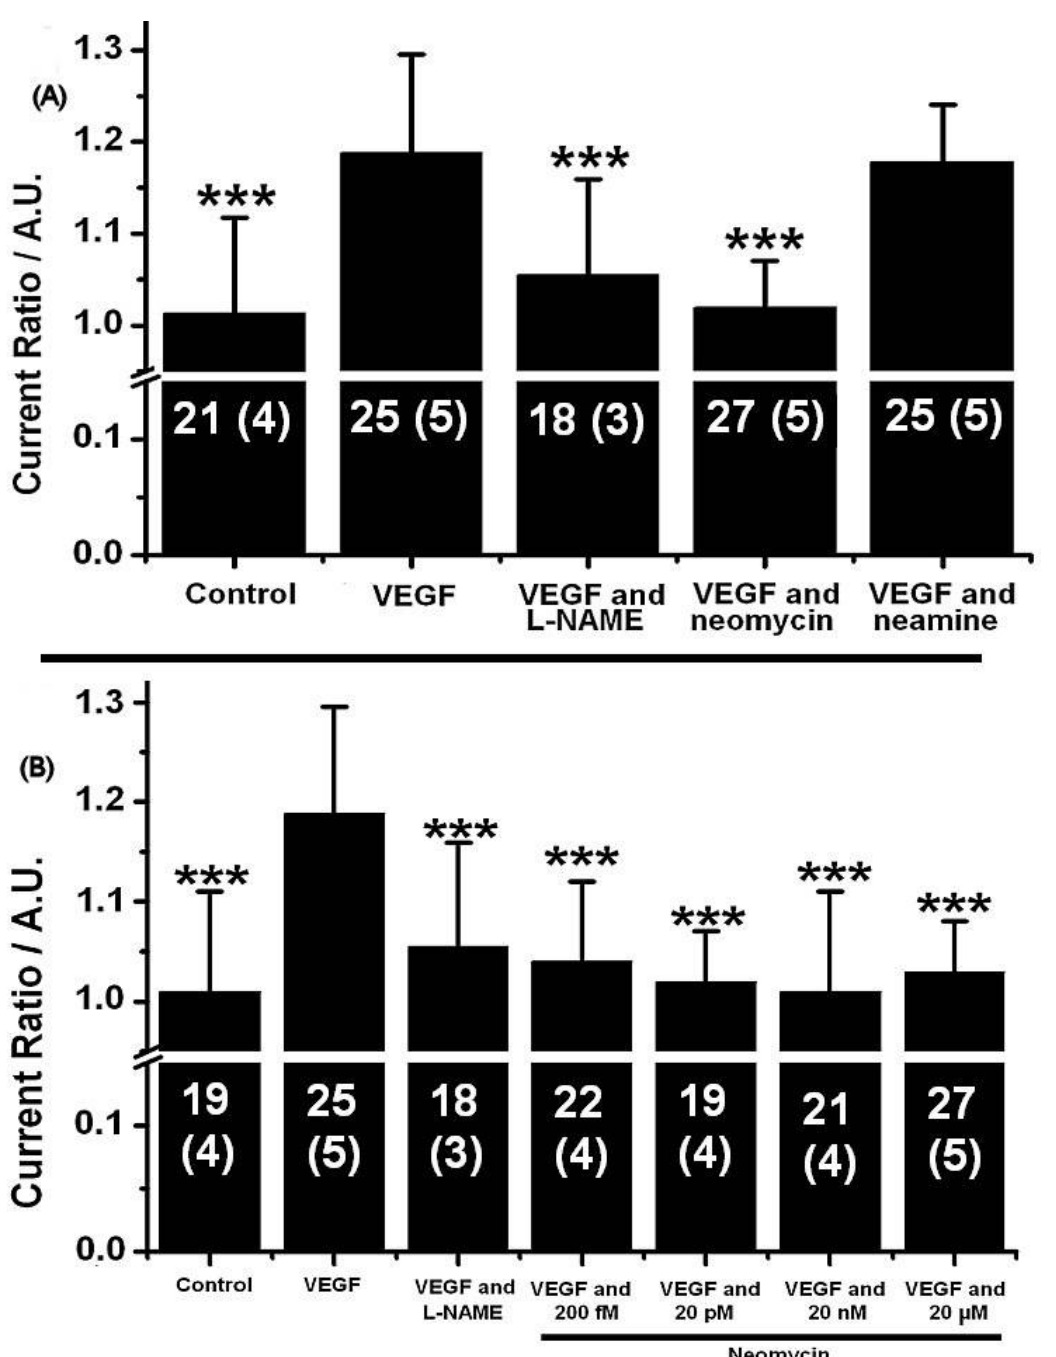
Figure 2. Effects of neomycin and neamine on VEGF-induced NO release. ( A ) Current ratios obtained for a 2 h exposure to 100 ng.mL −1 of VEGF in the presence of different inhibitors (neomycin, neamine, L-NAME). ( B ) Current ratios obtained for a 2 h exposure to 100 ng.mL −1 of VEGF in the presence of different concentrations of neomycin. The data shown here are average standard deviation. The graph shows the total number of measurements with the number of MMA used between brackets, for each condition: n = number of measurements (number of MMA). The values obtained were compared to the control case, where only VEGF was added using Student’s t -test, ***: p < 0.001. Compared to the control case, where no angiogenic factor is added, the addition of VEGF led to an 18.8% increase in the magnitude of the NO peak ( p < 0.001). This increase was completely abolished after addition of the NOS inhibitor L-NAME (100 µM, p < 0.001). This result clearly indicates that the increase in the 0.9 V peak is due to a higher NOS